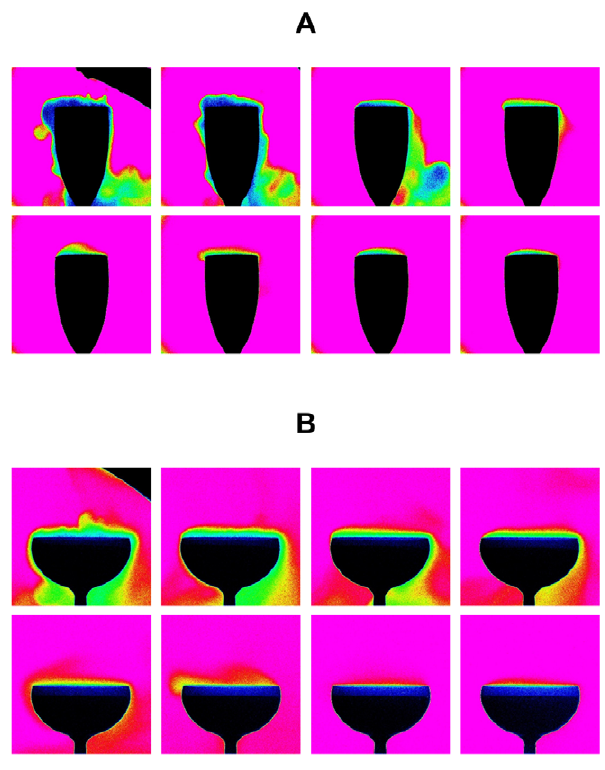
Figure 7. Infrared imaging of gaseous CO 2 desorbing from glasses filled with champagne. False color time-sequences illus- trating champagne glasses as seen through the objective of the IR video camera, after the pouring step – for a bottle stored at 20 u C – whether champagne is served into the flute (a) or into the coupe (b). Zones highly concentrated in gaseous CO 2 appear in black and dark blue, whereas zones slowly concentrated in gaseous CO 2 appear in red.